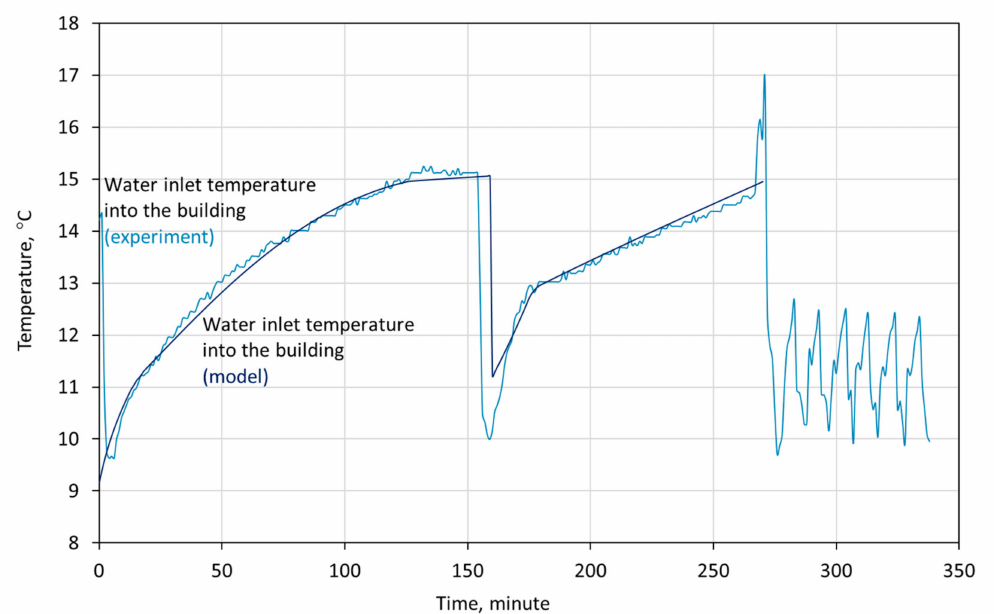
Figure 4. Comparison of the temperature of water flowing from the tanks in the process of cooling the